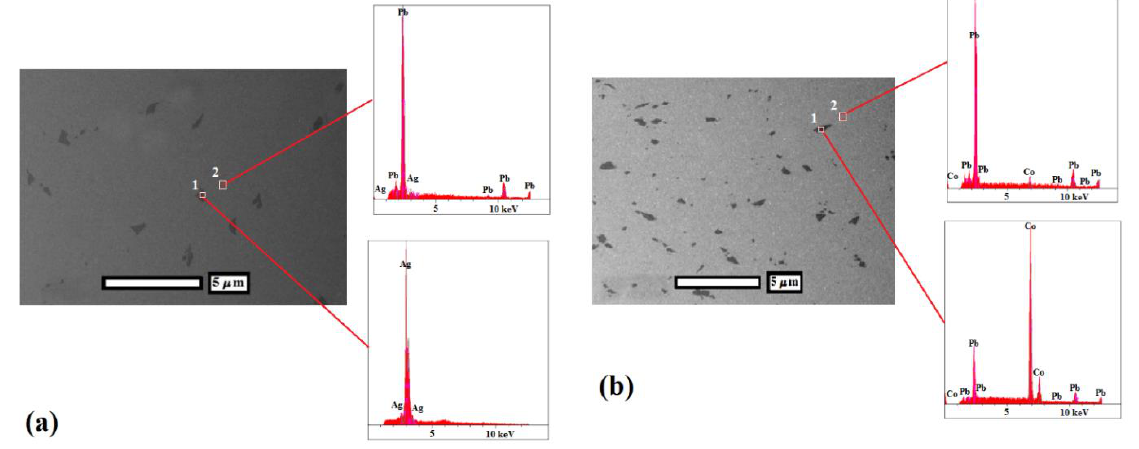
Figure 4. BSE and EDS analyses of ( a ) Ag/Pb and ( b ) Co/Pb composites after 10 ARB passes.